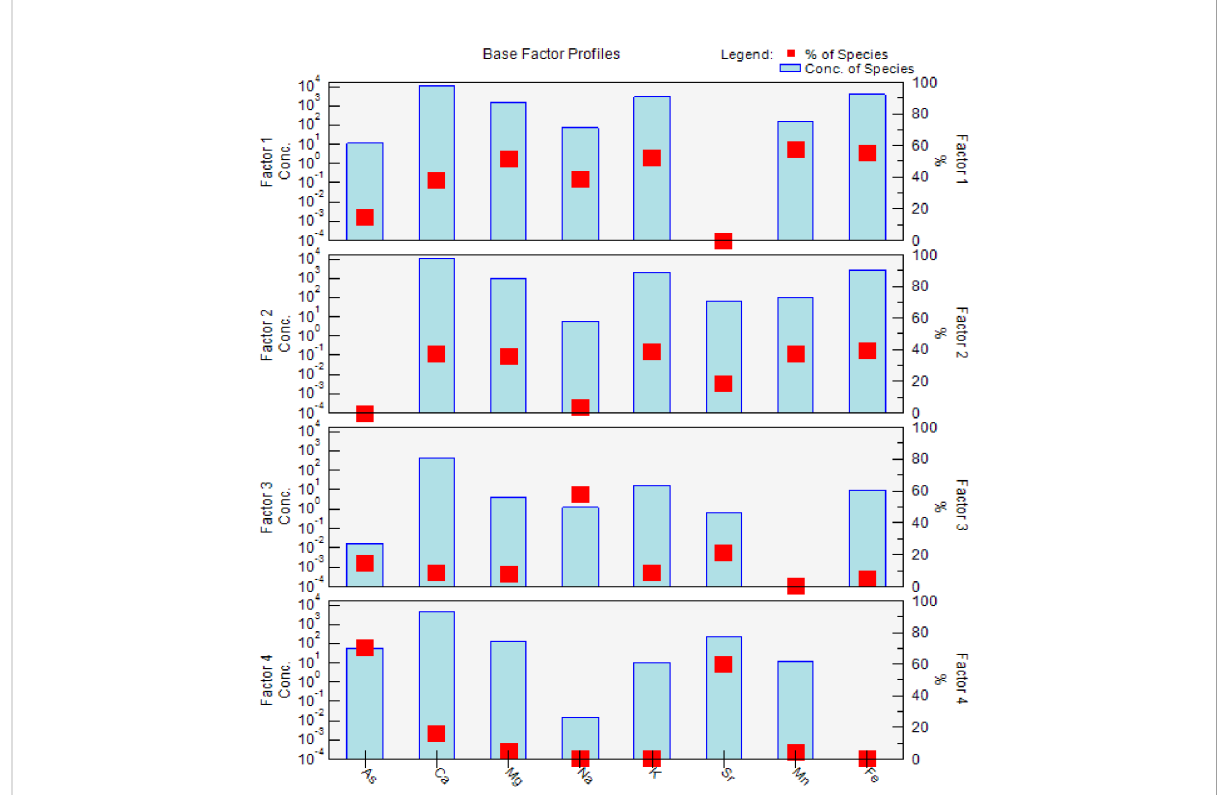
FIGURE 9 Factor pro fi les and source contributions of metal concentrations from PMF for agricultural